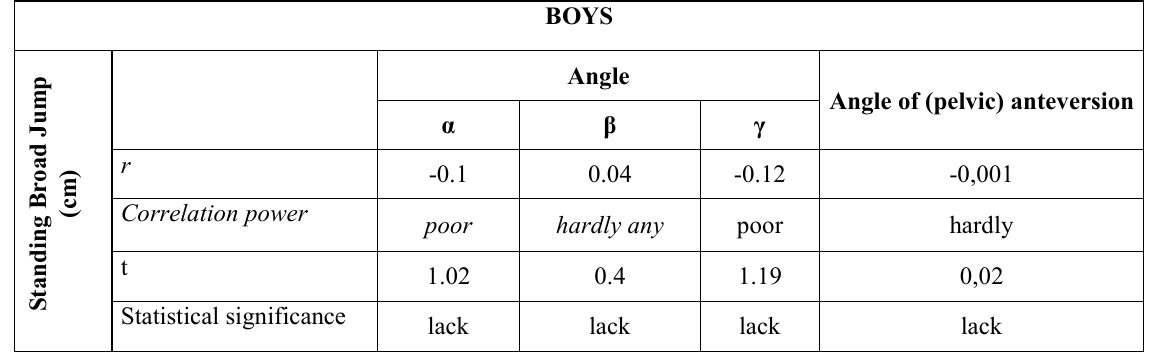
Correlations occurring between the angles characteristic of anterior-posterior pelvic tilts (upper thoracic - α, thoracic- lumbar - β, sacral-lumbar γ) and the angle of pelvic anteversion in the sagittal plane and the standing broad jump